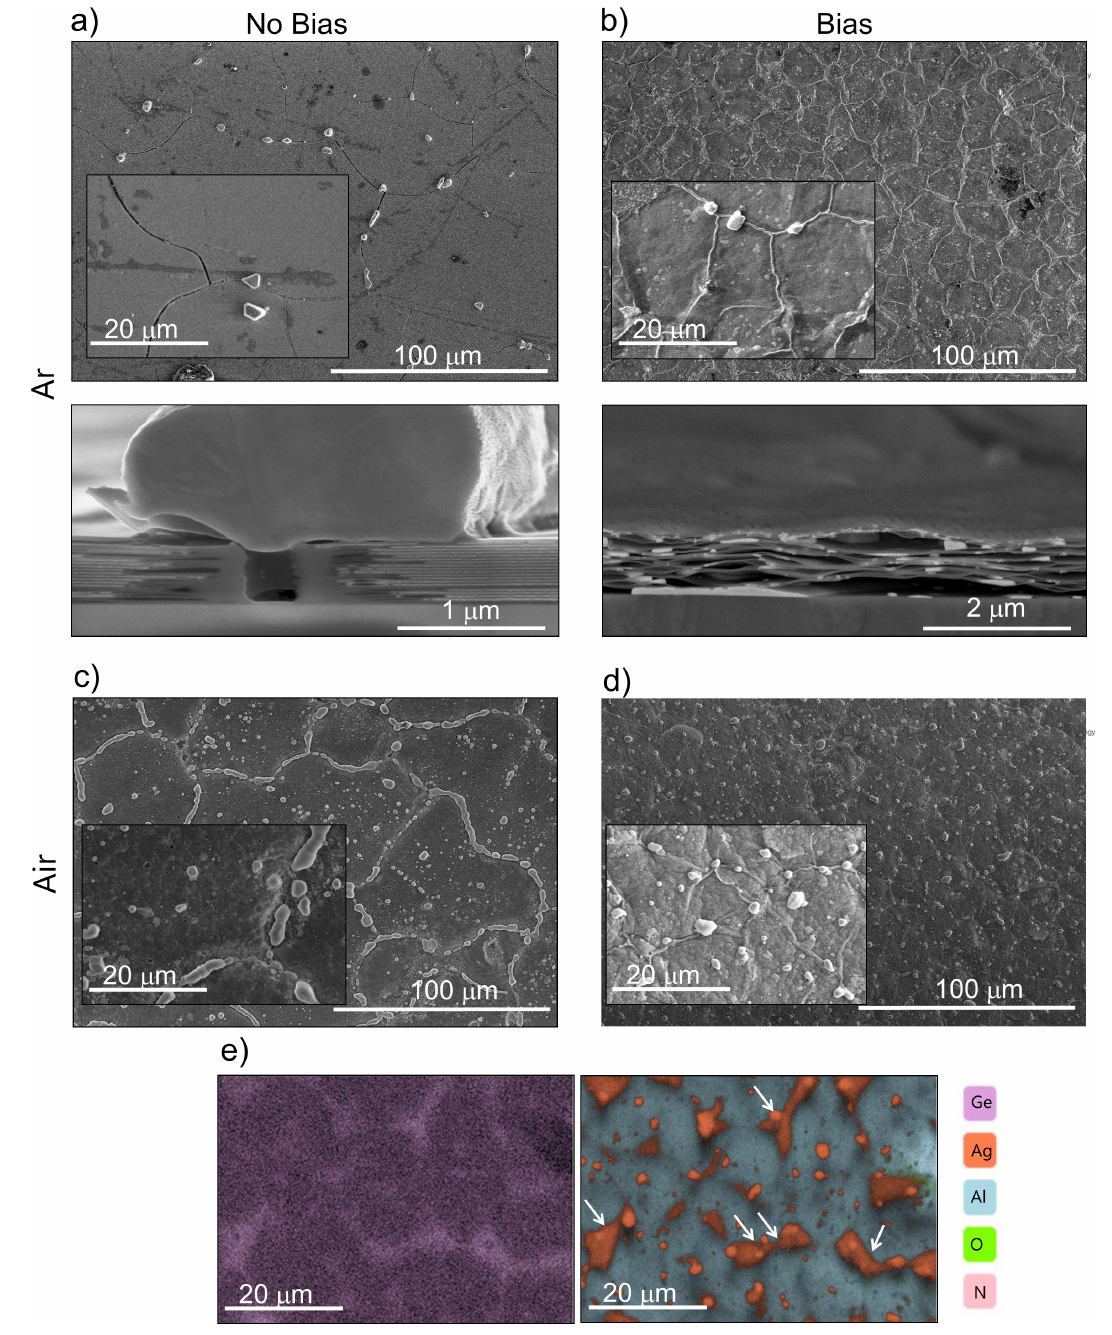
Figure 6. SEM micrographs in planar ( top ) and cross-sectional view ( bottom ) of the Ag[Ge]/AlN NMLs, as deposited without bias, after annealing at 700 ◦ C ( a ) in Ar and ( c ) in air. Corresponding SEM micrographs of the Ag[Ge]/AlN NMLs, as deposited witht bias, after annealing at 700 ◦ C ( b ) in Ar and ( d ) in air; ( e ) EDX mapping of ( d ) which shows that the surface particles are pure Ag and close to them there are Germanium-enrinched surface regions (indicated by